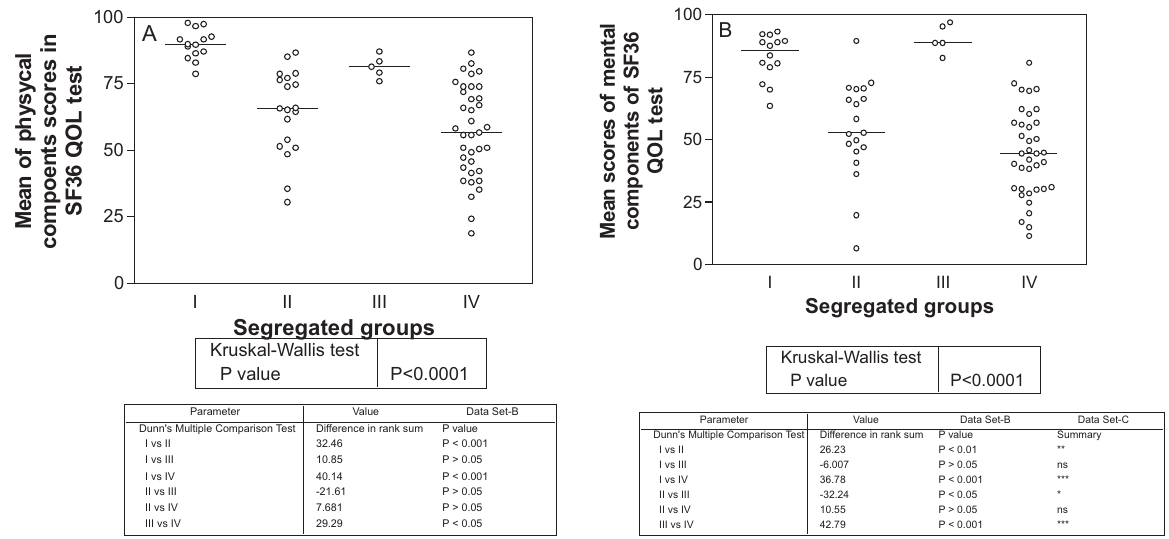
Figure 6 - Distribution of mean values of physical (A) and mental (B) components in the QoL SF36 tests of AD adult Brazilian patients, segregated by groups according methods and fig.3. Table shows analysis of variance and post-hoc comparison (Dunns test) between segregated